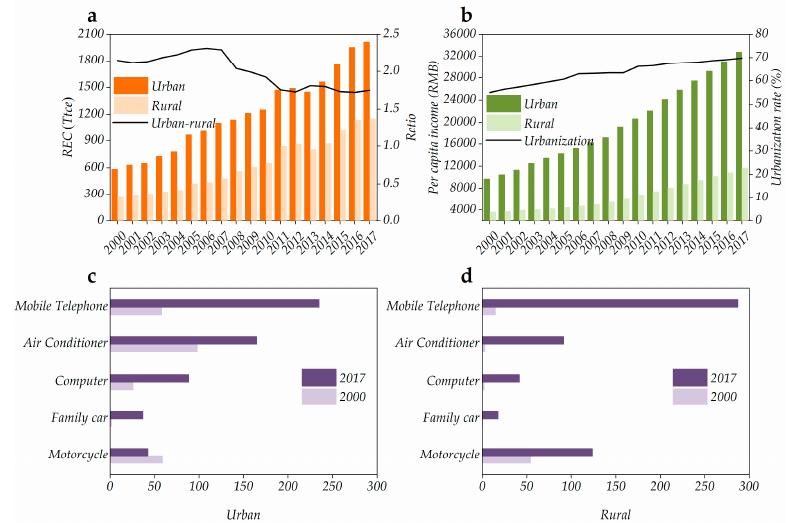
Figure 2. Trends of REC and related indicators in urban and rural Guangdong during 2000–2017. ( a ) Total REC and the ratio of urban to rural. ( b ) Per capita income and urbanization rate. ( c ) Ownership of major durable consumer goods per 100 urban households. ( d ) Ownership of major durable consumer goods per 100 rural households.